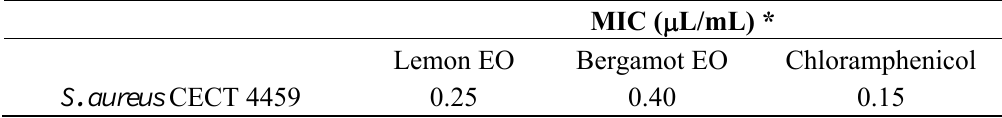
Table 3. Minimal inhibitory concentrations values from citrus EOs using broth microdilution